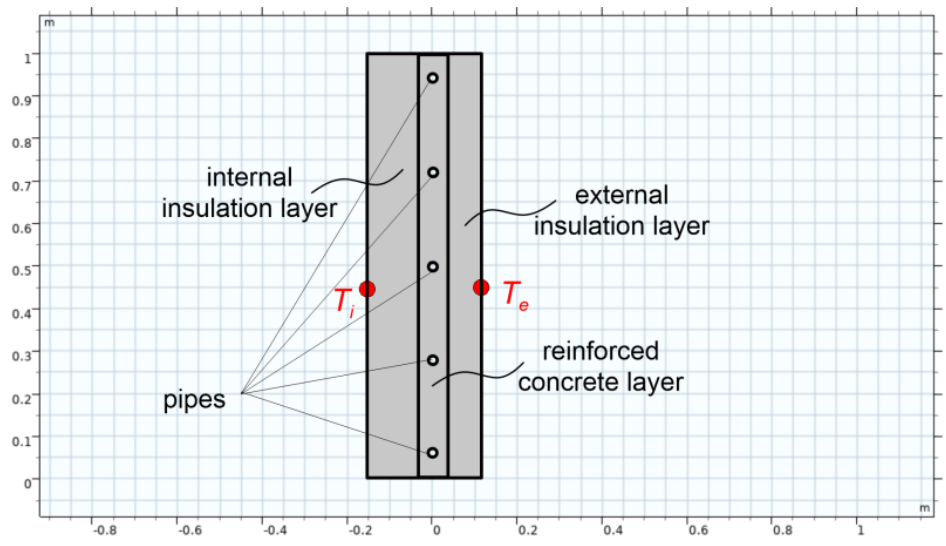
Figure 4. The geometry of the simulated system. Table 1. Mesh independence results.